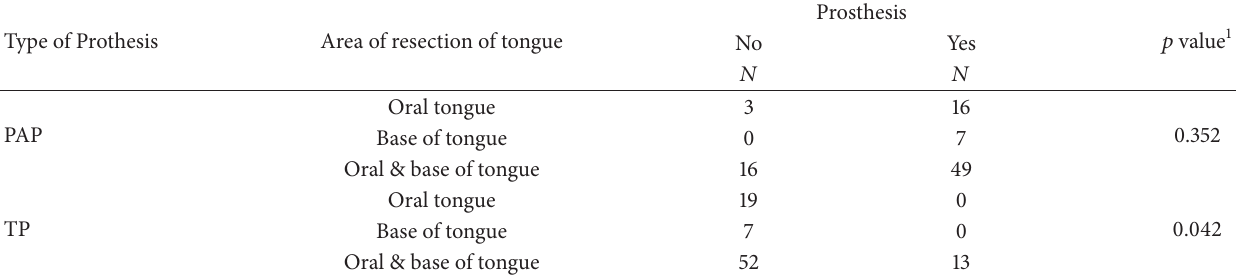
Table 4: Area of resection of tongue and palatal augmentation prosthesis (PAP) or tongue prosthesis (TP). Type of Prothesis Area of resection of